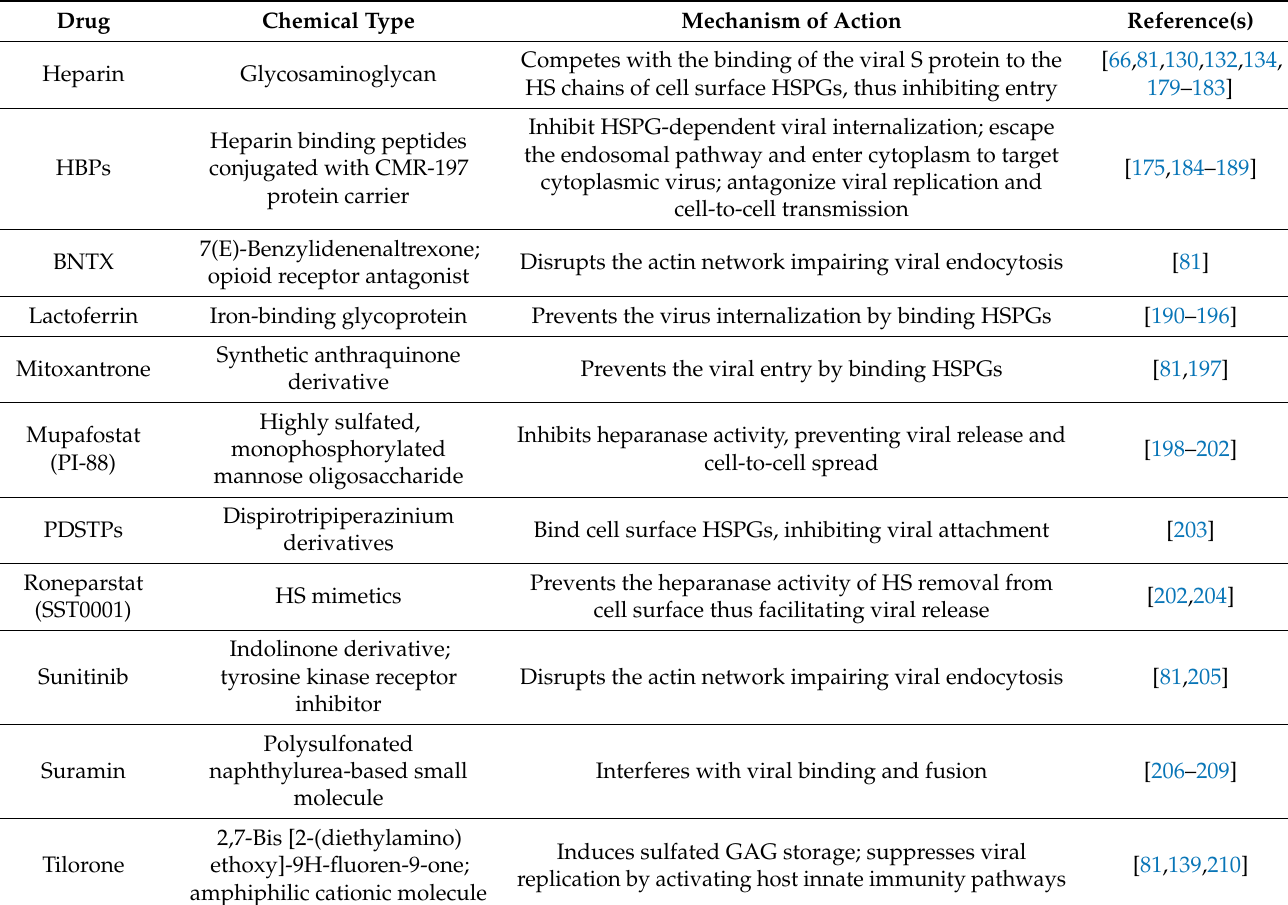
Table 3. HSPG-targeting therapeutics that might be useful against SARS-CoV-2 infection.